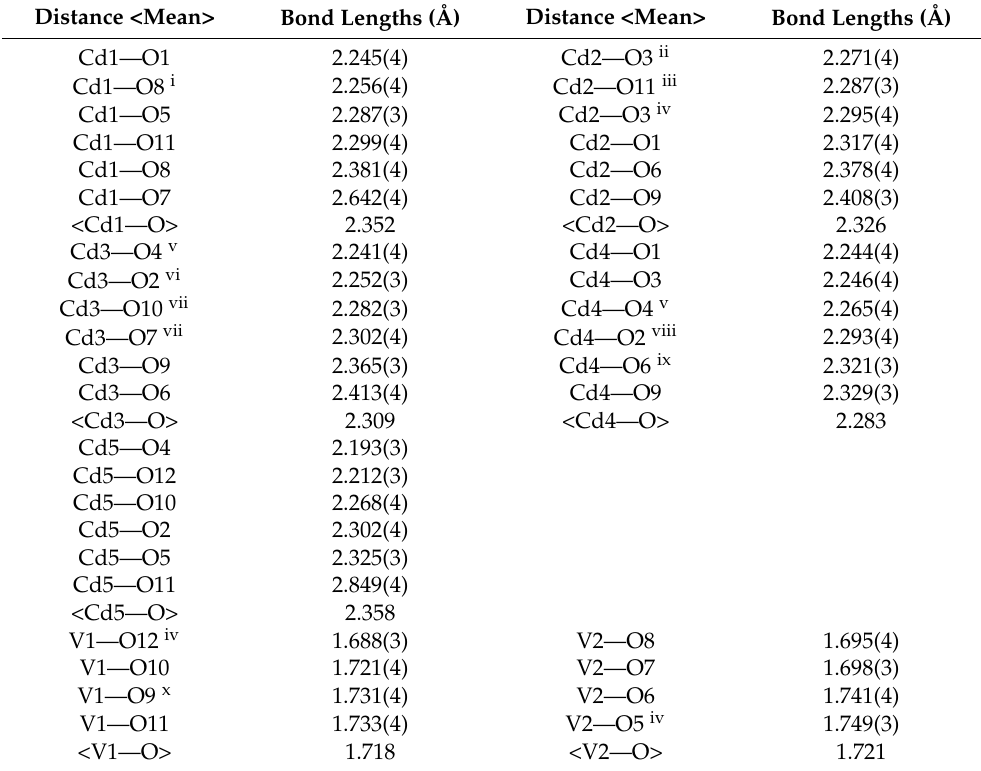
Table 3. Bond distances and average lengths (Å) for Cd 5 (VO 4 ) 2 (OH) 4 .